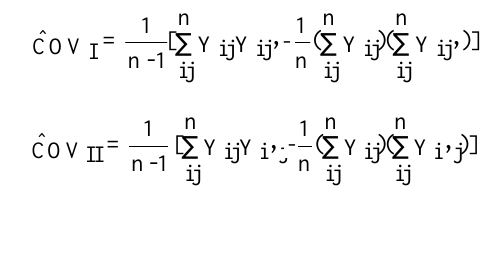
Table V - Analysis of variance of two-way tables representing s diagonals of group I.